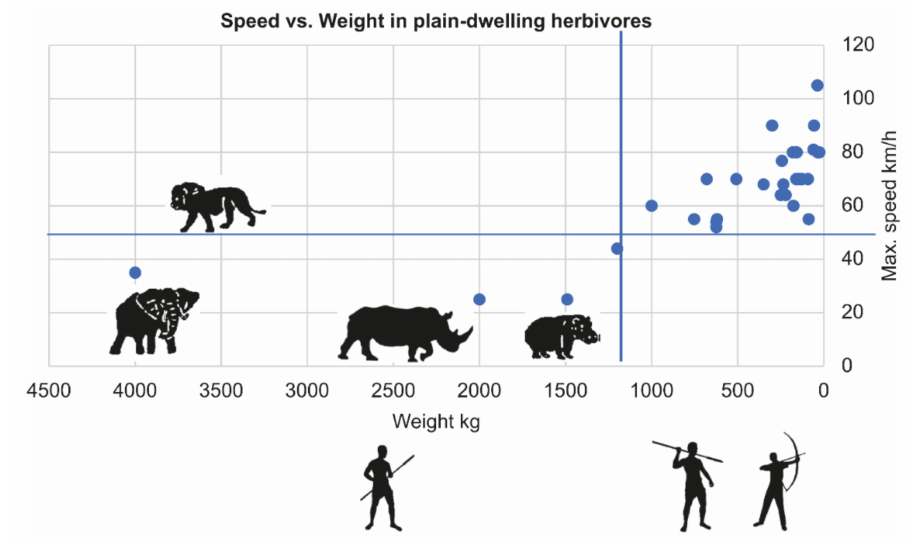
Figure 3. Hunting methods as a function of prey weight and maximum speed. Megaherbivores (>1000 kg) are slower than a lion (horizontal line), so they do not rely on escape as a predation prevention strategy. Data in [27]. Composite projectile weaponry is required to hunt smaller and faster